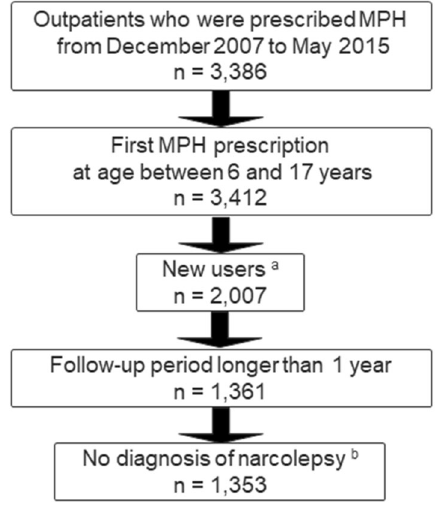
Figure 3. Participants’ flow diagram. a New users: patients who had not been prescribed MPH within 1 year prior to their first prescription month during our observation period. b No diagnosis of narcolepsy: patients who were prescribed OROS-MPH were chosen. MPH, methylphenidate hydrochloride; OROS-MPH, osmotic- release oral system methylphenidate